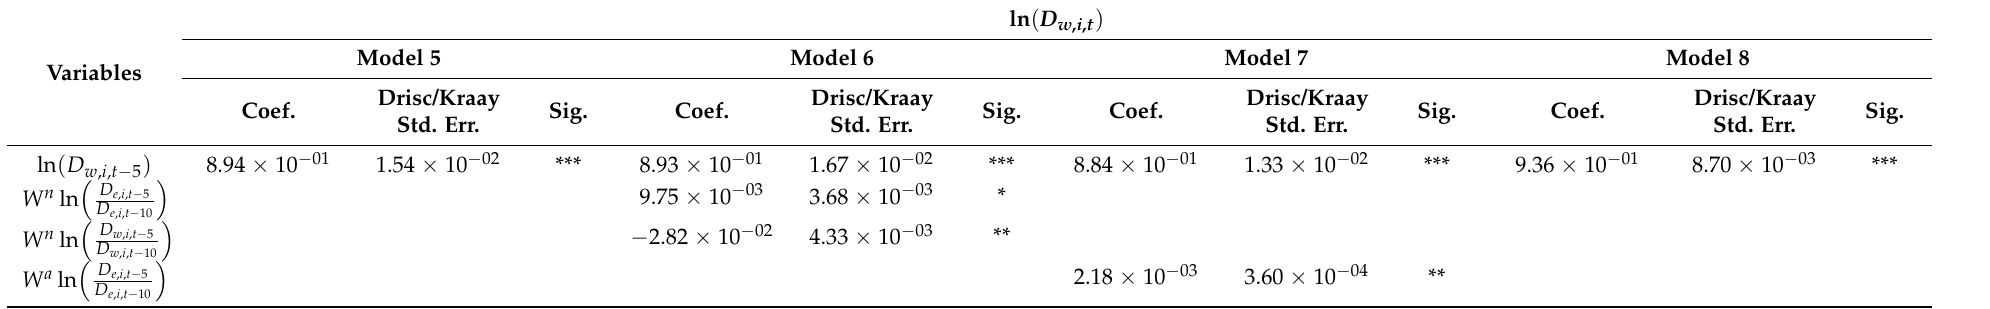
Table 2. Predicting worker density based on three different spatial